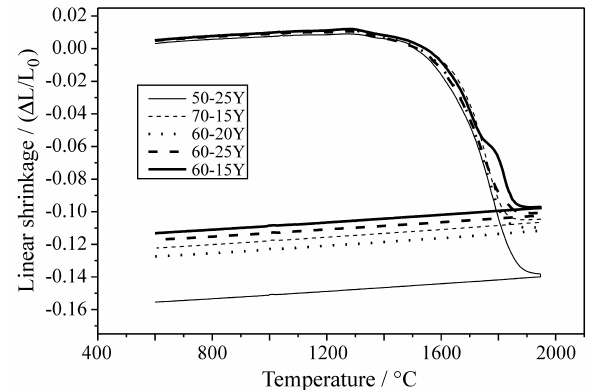
Fi gu re 5. Di la to me tric re sults in ar gon: li ne ar shrin ka ge ver sus tem - pe ra tu re for se ve ral com po si ti ons.